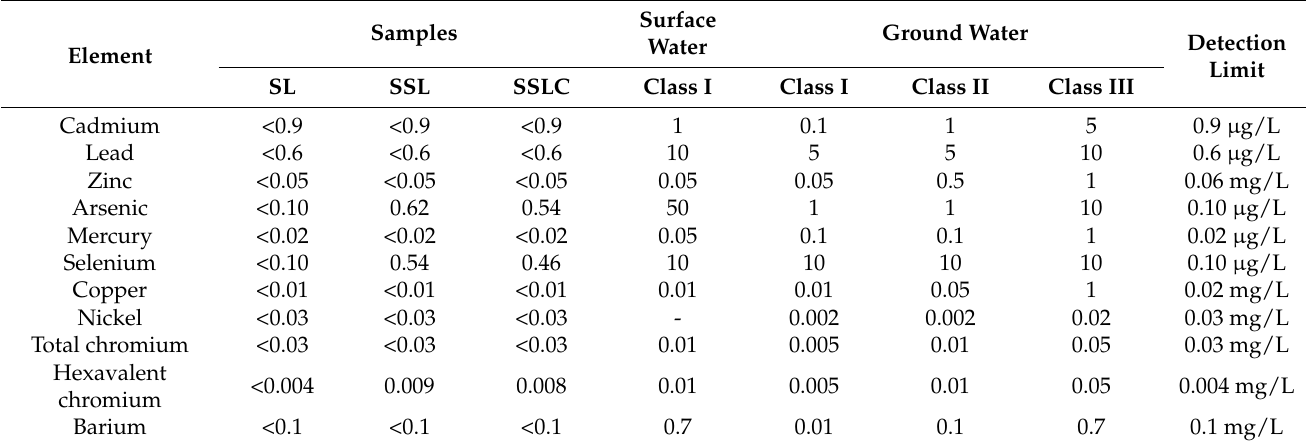
Table 5. The composition analysis results of infiltration